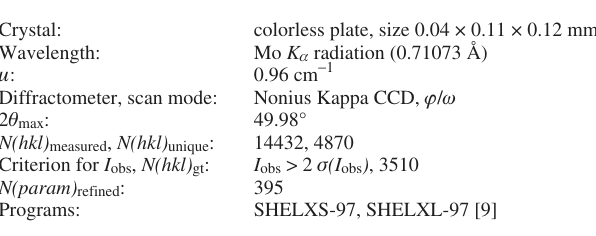
Table 1. Data collection and handling.